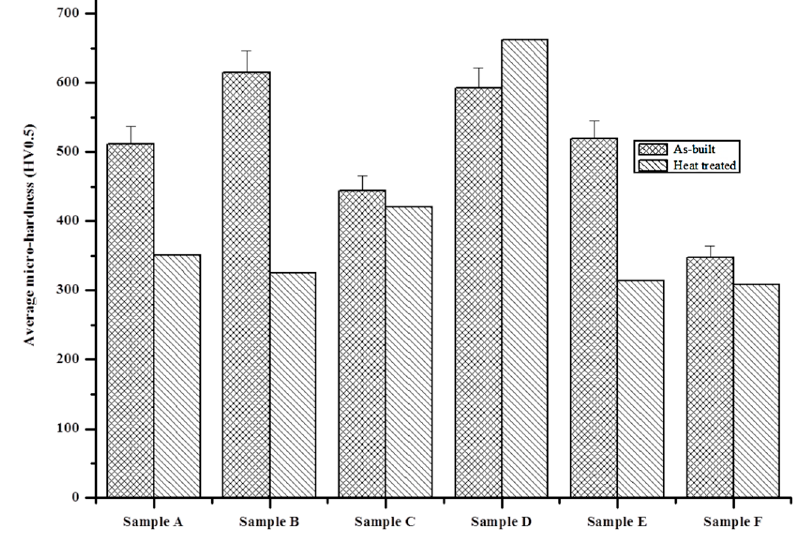
Figure 10. Overall hardness of the alloys compared.